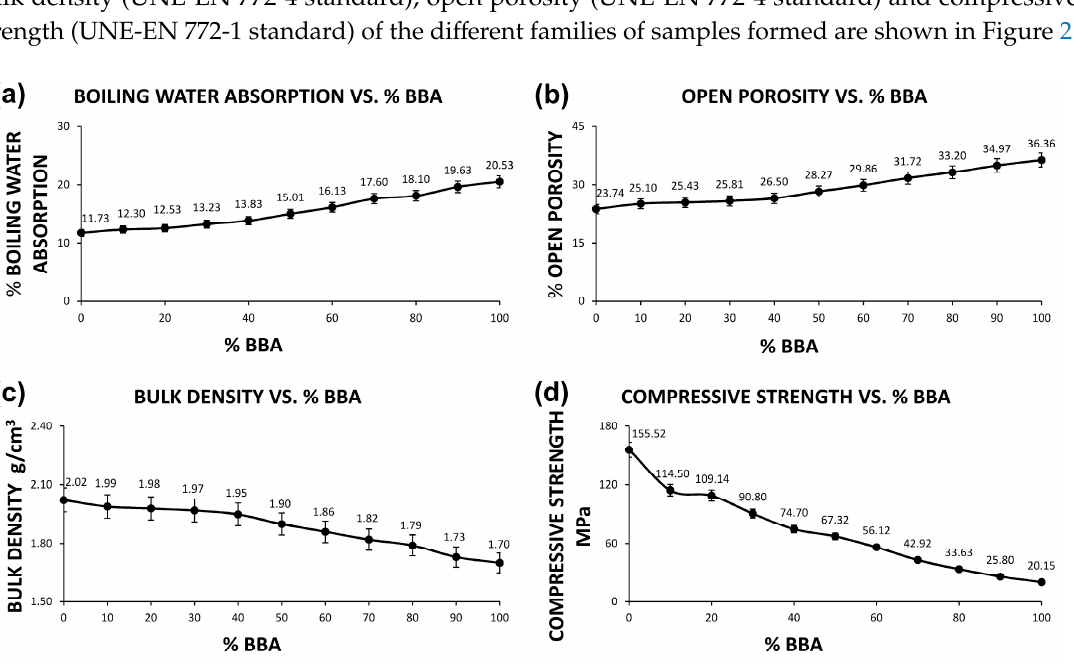
Figure 2. Graphs of the different physical and mechanical properties of ceramics as a function of the percentage of biomass bottom ash: ( a ) boiling water absorption, ( b ) open porosity, ( c ) bulk density and ( d ) compressive strength.